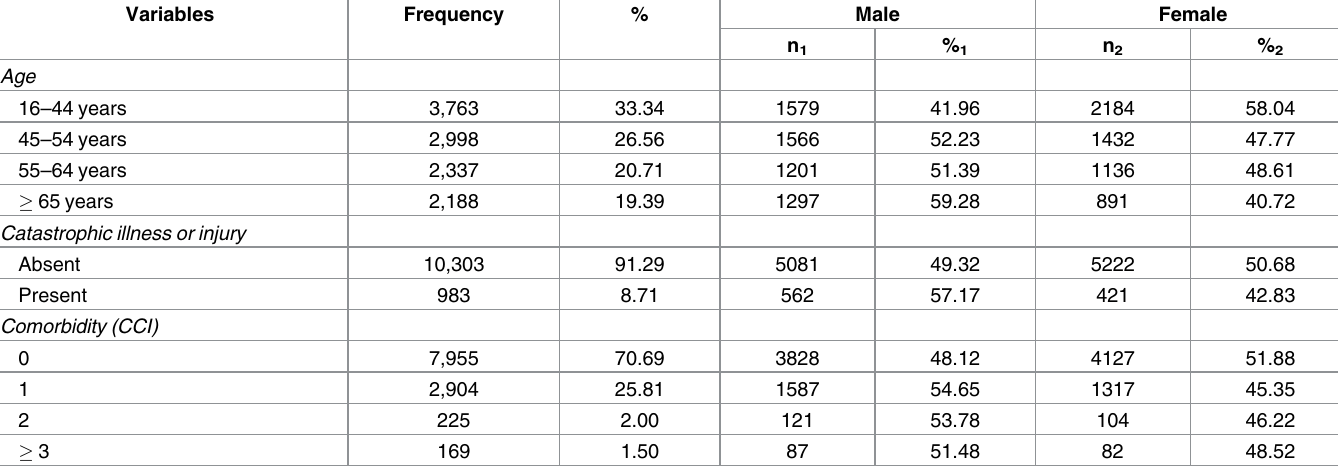
Table 2. Characteristics of the study couples during 2002–2013(N = 5,643 couples 1